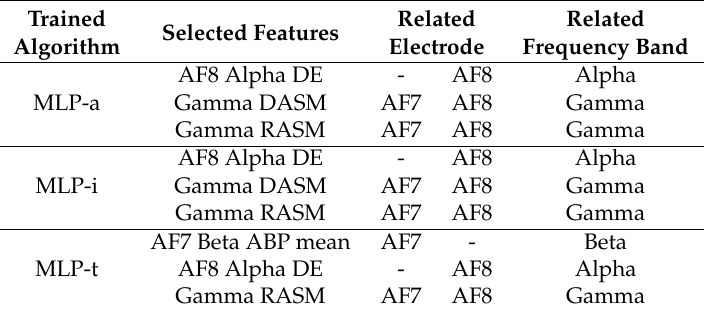
Table 8. WSE results by algorithm and its option.